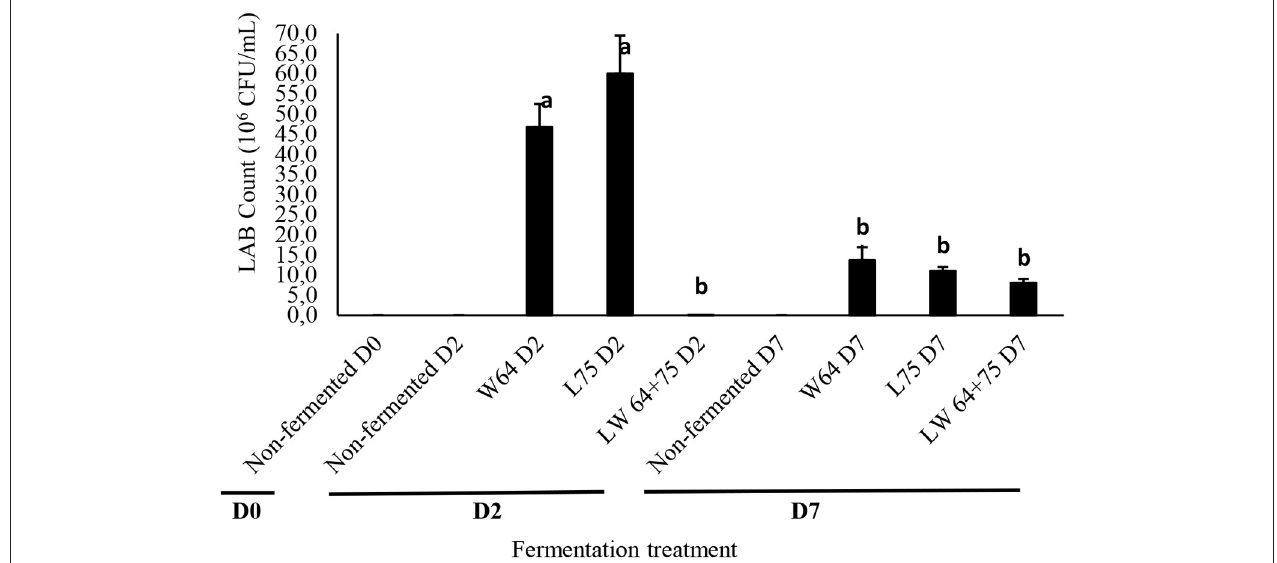
FIGURE 4 | Surviving LAB count in fermented smoothies. Bars with similar alphabetic letters are not significantly different at p < 0.0001 level. W64, Weissella cibaria 64; L75, Lactobacillus plantarum 75 ; LW64 + 75, W. cibaria 64 + L. plantarum 75; D0, day 0; D2, 2 days; D7, 7 days; non-fermented smoothies